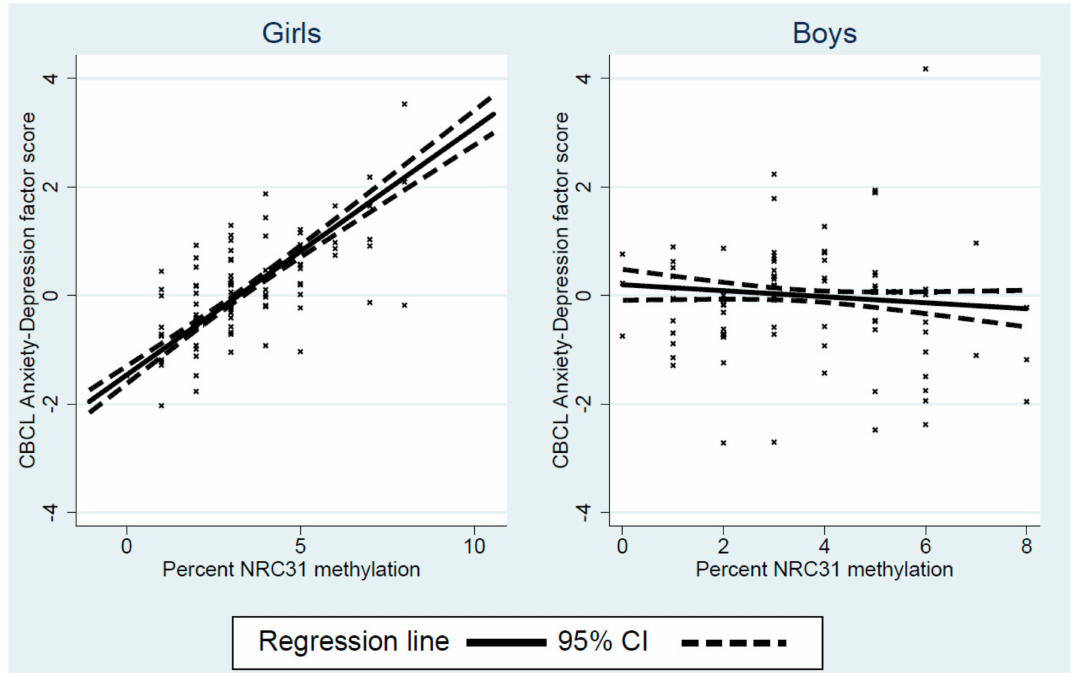
Figure 5. Regression line (and 95% CI) for the association between NRC31 1-F promoter methylation and child anxiety-depression symptoms in girls and boys. The figure also shows a scatterplot of the